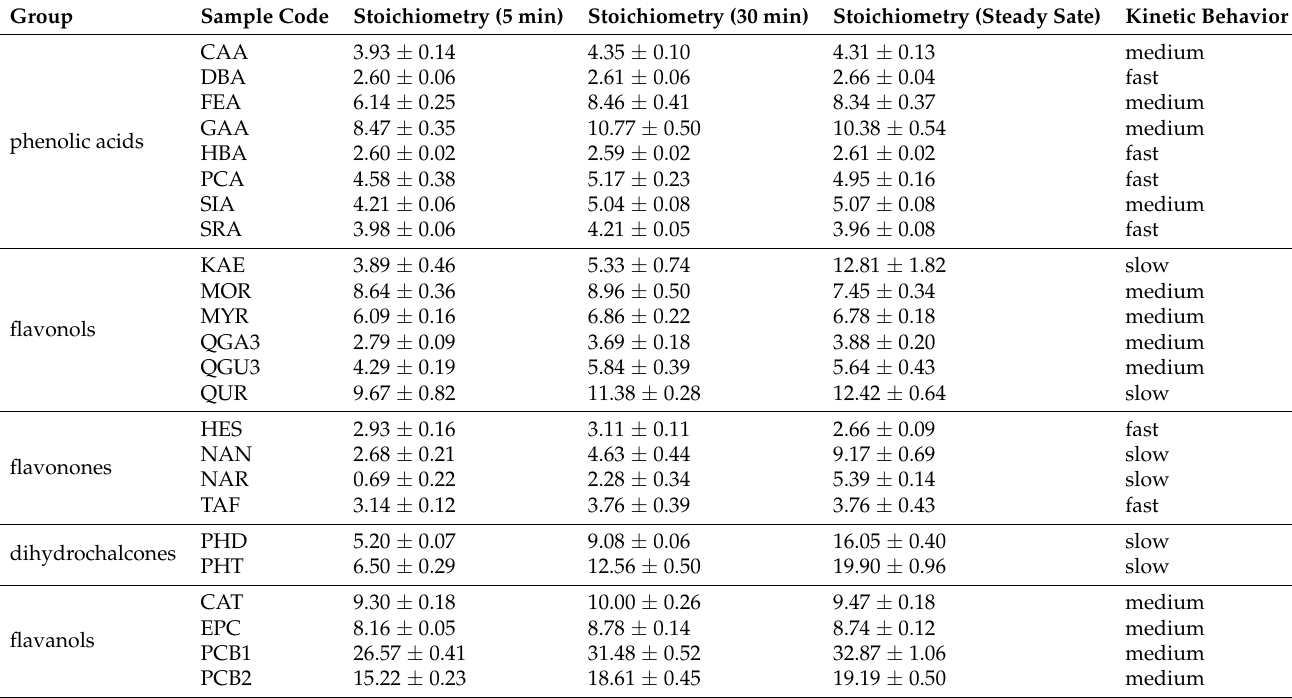
Table 3. Results of the ABTS assay presented as stoichiometry values after 5 and 30min and stationary final values and kinetic behaviors. Data are mean values of three measurements and standard errors. Sample names and structures are shown in Table